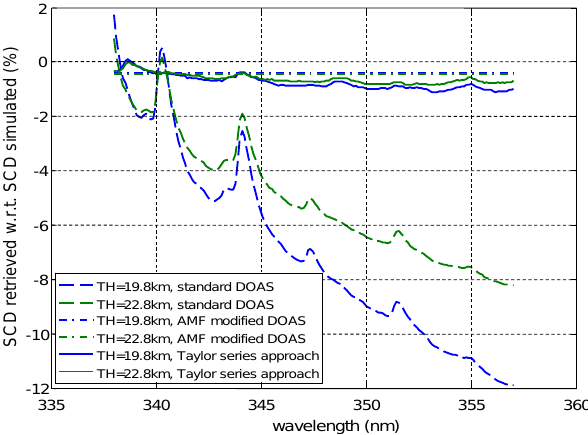
Fig. 3. Relative difference between the retrieved and the true (sim- ulated) ozone SCDs using different approaches. Plots are for two THs near the peak of the BrO profile (19.8 and 22.8km). The same relative differences are valid also for the relation between fitted and true optical